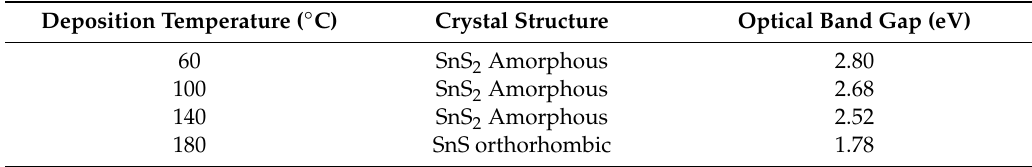
Table 1. The summaries of crystal structure and optical band gap for each deposition temperature. Deposition Temperature ( ◦